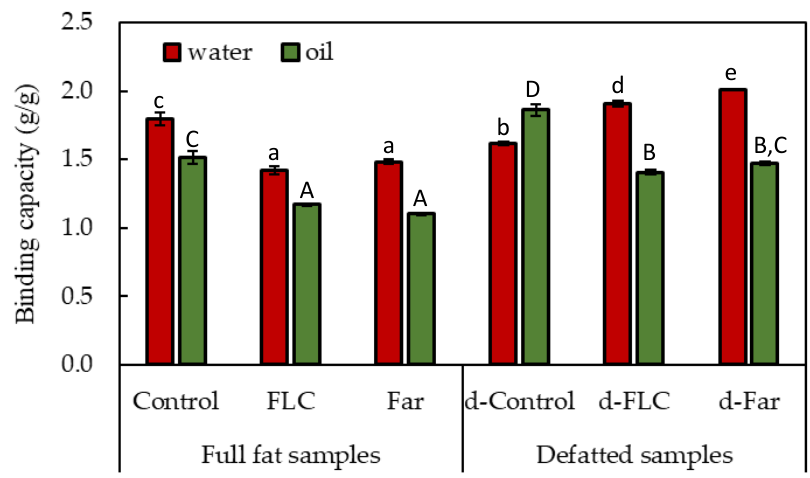
Figure 2. Water (WBC, red) and oil (OBC, green) binding capacity of full fat (Control, FLC and Far) and defatted (d-Control, d-FLC, d-Far) mealworm powders. Data are expressed as mean ± standard deviations ( n = 3). Different letters (a,b,c,d,e for WBC and A,B,C,D for OBC) indicate significant ( p < 0.05) differences between means.